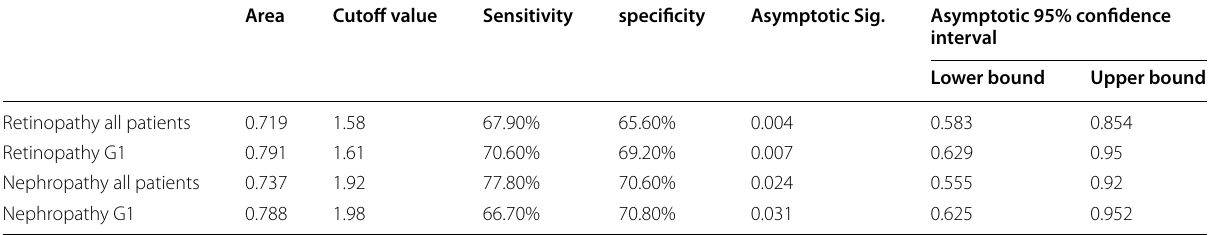
Table 3 ROC curve analysis for diagnosis